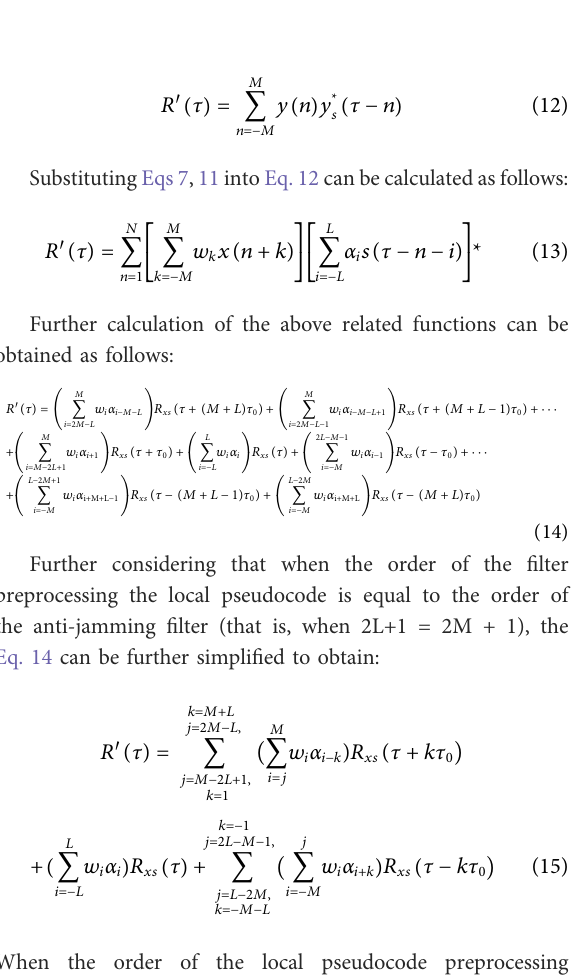
FIGURE 8 Robust ranging algorithm fl ow